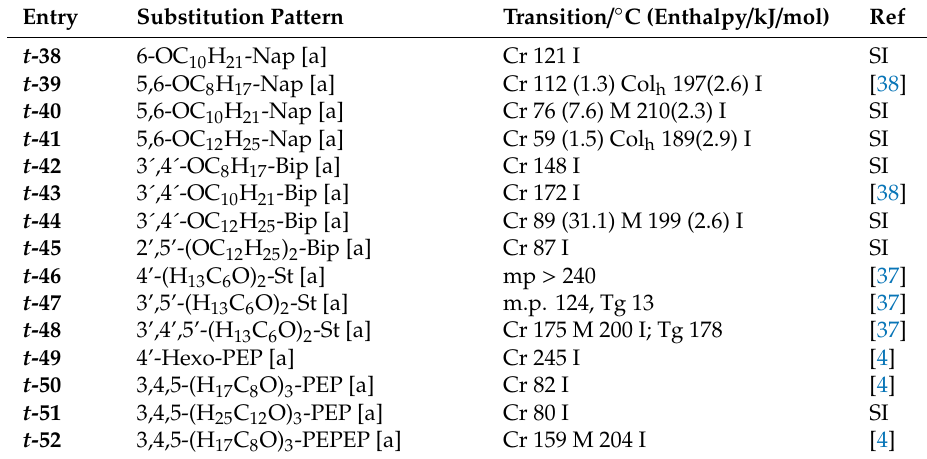
Table 2. t -TTTs with extended p-systems and data from thermal analysis.